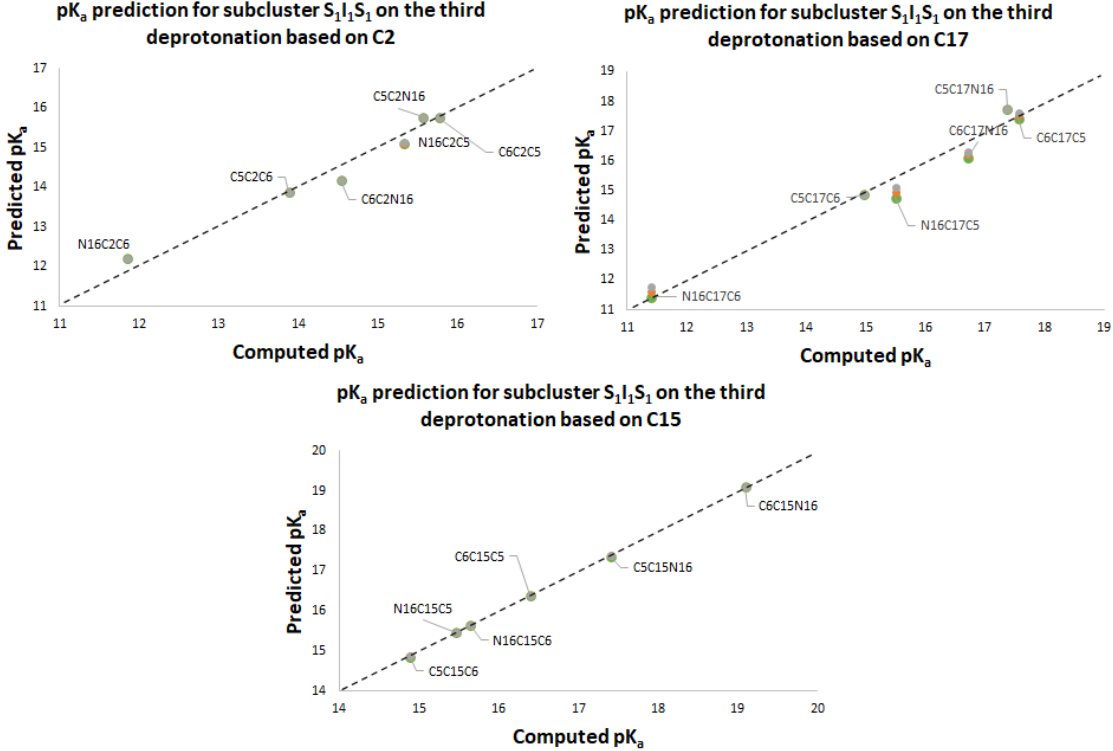
Figure 19. pK a prediction for the third deprotonation. Subclusters S 1 I 1 S 1 based on C2, C17, and C15. Predictions are marked as gray (max), orange (mean), and green (min).